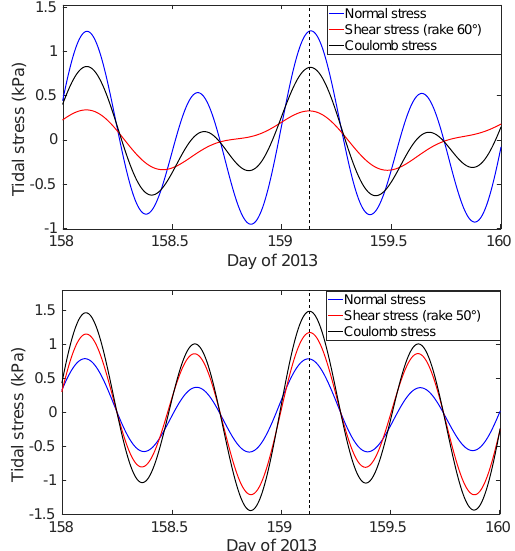
Figure 13. Modeling of solid Earth and ocean tidal stress perturbations on the fault plane candi- dates of the June 2013 SSE. Coulomb stress changes in the direction of geological slip on the plane (rake = 60–70 ◦ ) are maximal at the time of the SSE initiation (depicted by vertical black dashed line). Figure adapted from Canitano et al. (2019) [5].